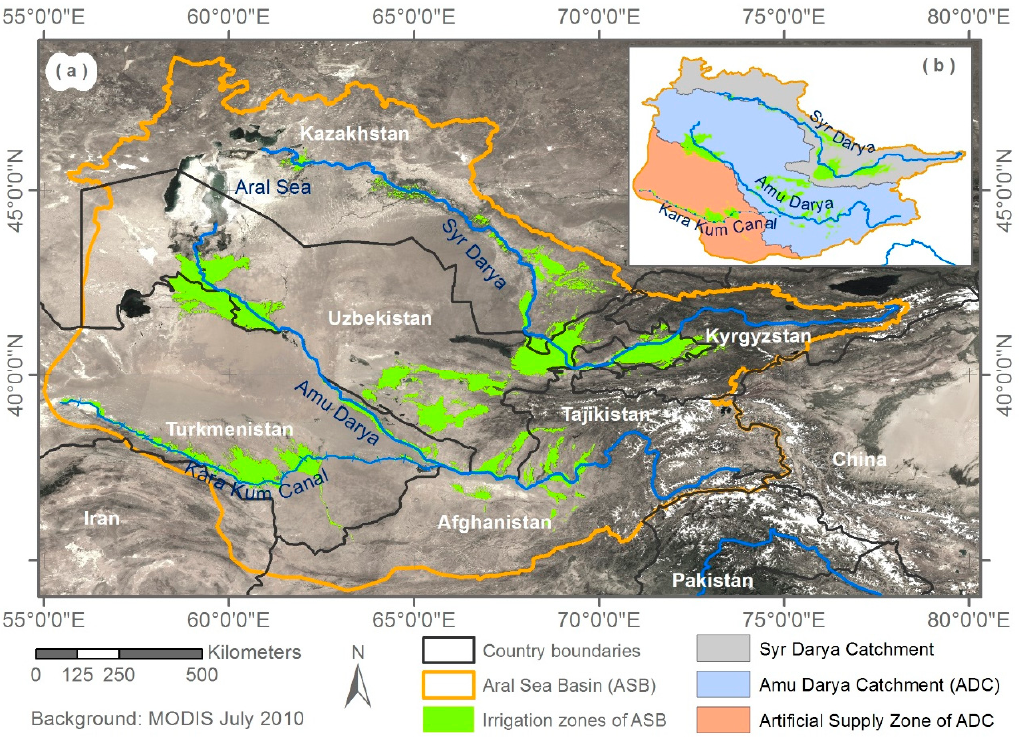
Figure 1. ( a ) MODIS MOD09 1 km map showing the Aral Sea Basin, the two main receiving waters, and the Kara Kum Canal, the irrigation planning zones in the ASB are colored green; ( b ) overview on the Amu Darya and Syr Darya Catchments as well as the artificial water supply zone introduced by the Kara Kum Canal.